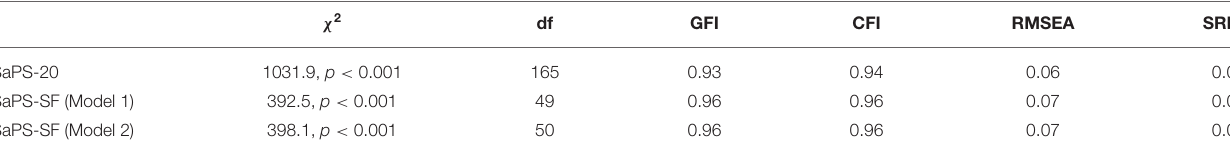
TABLE 2 | CFA goodness-of-fit indices for the SaPS-20 and SaPS-SF.